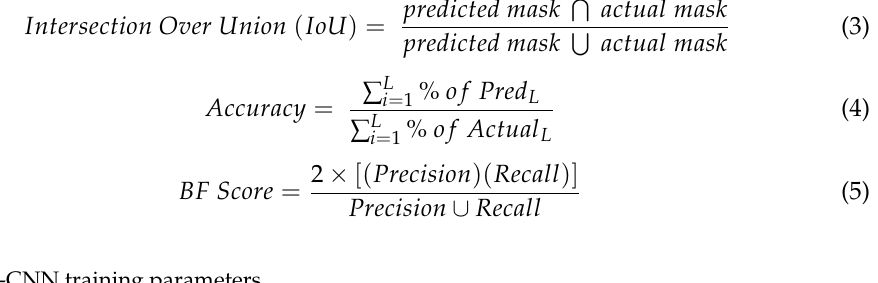
Table 4. Di-CNN training